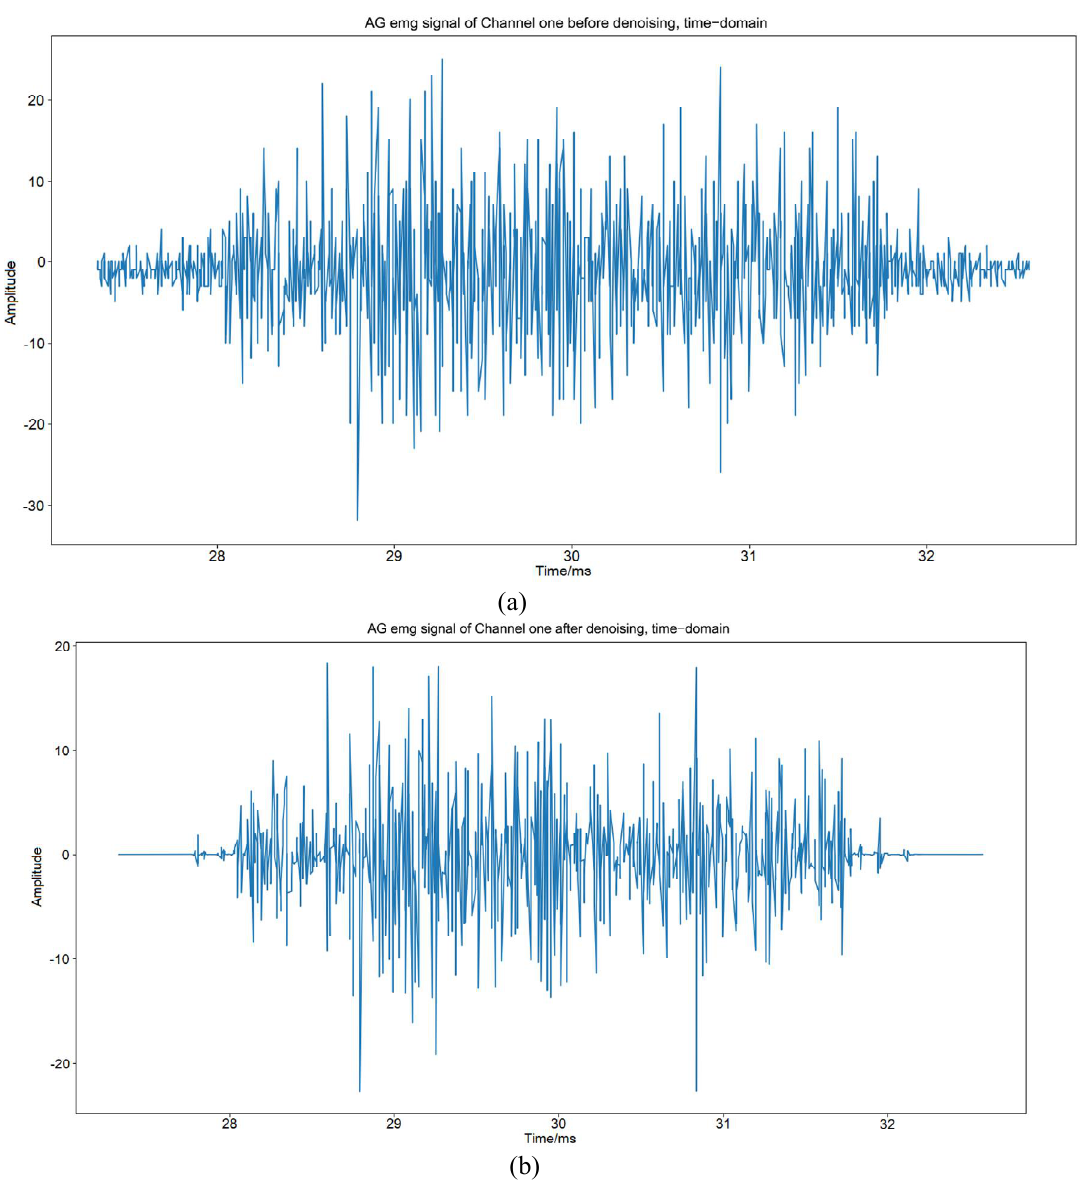
Figure 5. ( a ) The AG SEMG raw signal; ( b ) AG SEMG signal of channel one after wavelet transform noise reduction.